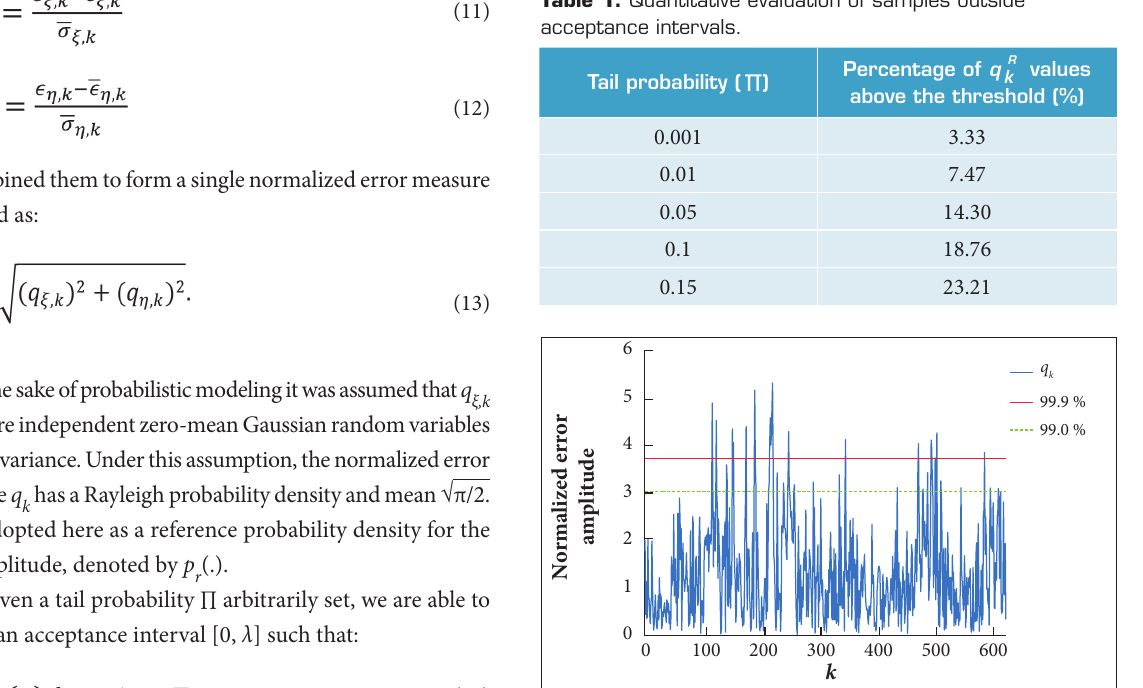
Figure 6. Normalized amplitude of IMMPDAF errors obtained with real measurements.